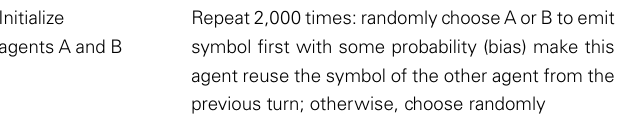
TableA1 | Procedure for generating 2,000-element coupled symbol sequence.